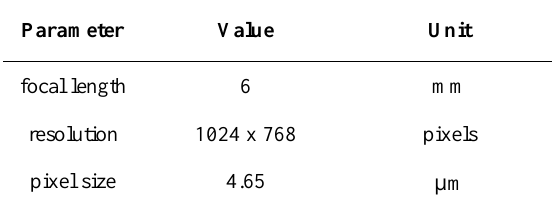
Table 5. Specification of the camera